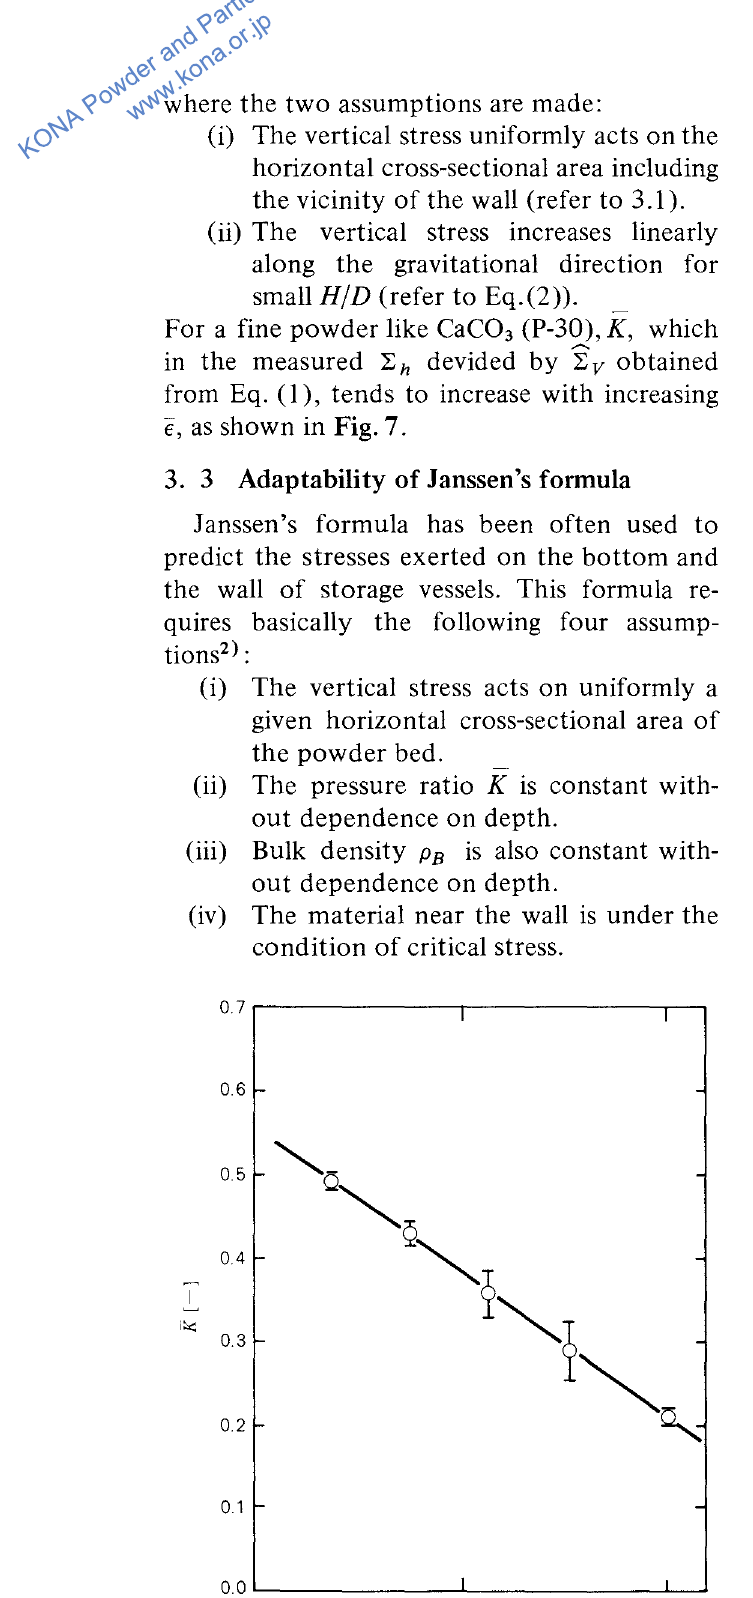
Fig. 7 Relationship between the ratio of horizontal stress to vertical stress and the porosity in the shallow bin